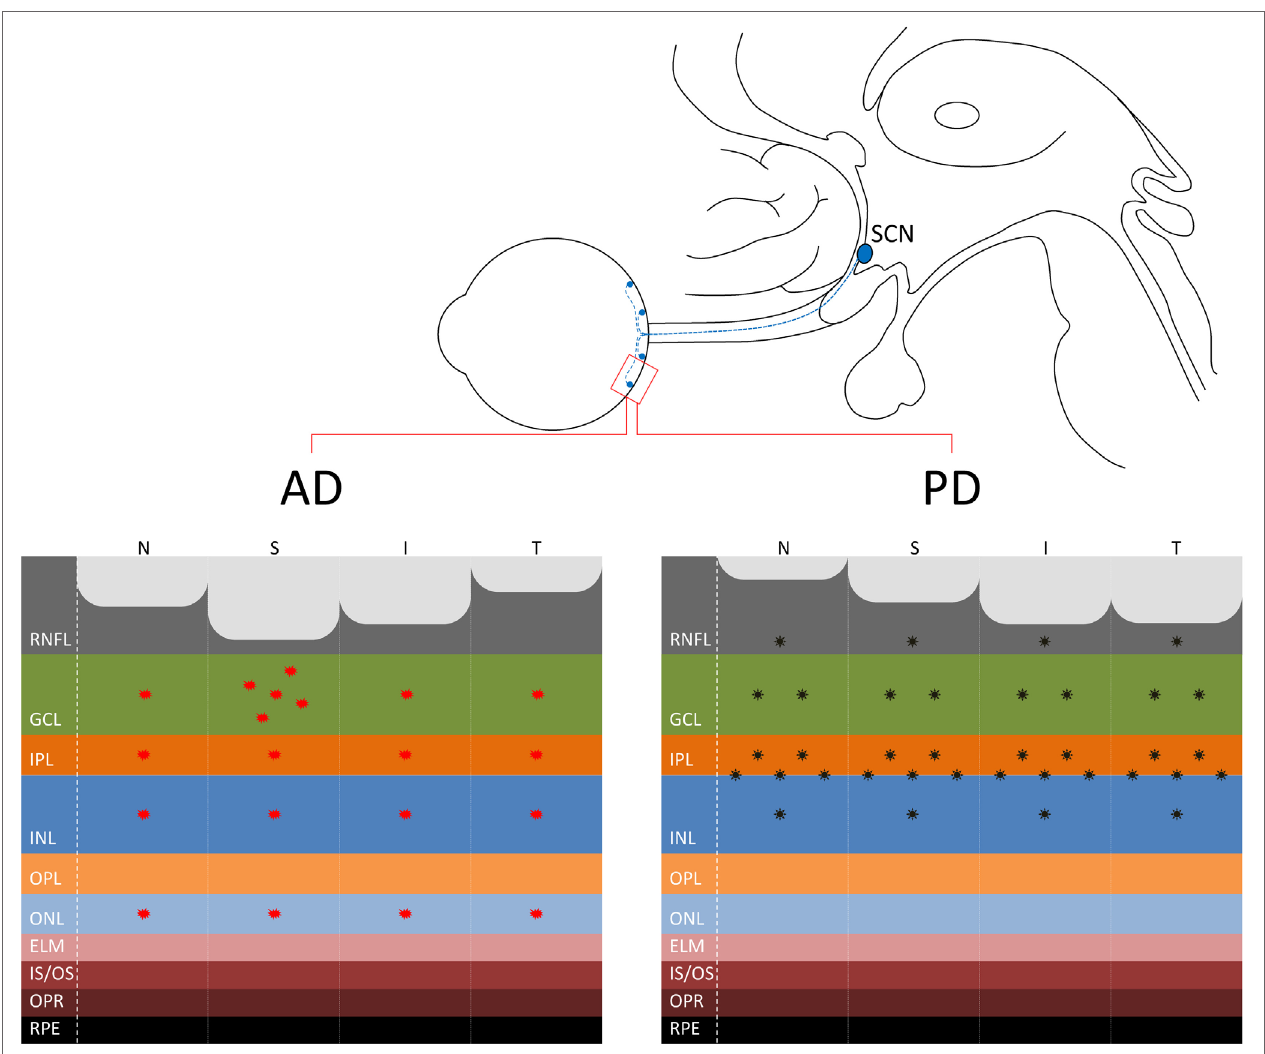
FiGURe 1 | (Upper panel) The connection between the eye and the suprachiasmatic nucleus (SCN) of the hypothalamus through the retinohypothalamic tract, originating in the retina from melanopsin-containing retinal ganglion cells (mRGCs) (in blue), is shown. (Lower panel) At the retina level, where are located also the mRGCs, the distinct pattern of axonal loss [retinal nerve fiber layer (RNFL) thinning] demonstrated by optical coherence tomography studies is reported for Alzheimer’s disease (AD) (21) with a more pronounced loss in the superior quadrant (left) and Parkinson’s disease (PD) with a more evident loss in the infero-temporal quadrants of the optic nerve (44, 46, 49) (right). Moreover, the figure depicts the pattern of β -amyloid deposition in AD, more evident in the superior quadrant and ganglion cell layer (GCL) [for a review, see Ref. (30)], and α -synuclein in PD in the inner retina and in particular at the inner plexiform layer (IPL)–inner nuclear layer (INL) interface (51,